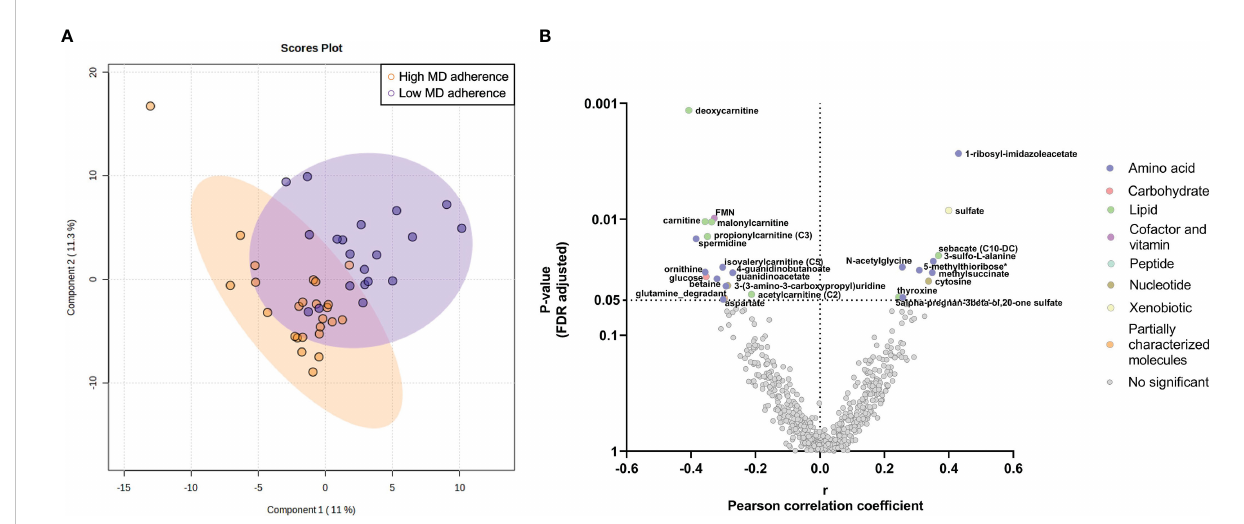
FIGURE 2 Endometrial metabolomic signature analysis in women with high and low adherence to Mediterranean Diet (MD). (A) Multivariate Partial Least Squares Discriminant Analysis scores plot from women with high and low MD adherence. (B) Partial correlation analyses between the MD global score and the endometrial metabolome. The X-axis represents Pearson partial correlations coef fi cients, whereas the Y-axis represents the FDR- adjusted p -values of the correlations. Grey dots represent non-signi fi cant correlations, whereas colored dots represent statistically signi fi cant correlations ( p -value<0.05 after FDR